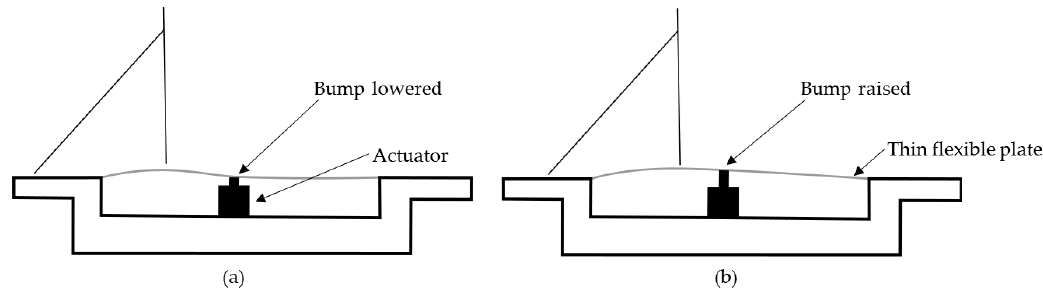
Figure 12. Schlieren images of an actuated flexible plate with ( a ) retracted and ( b ) extended actuator in a wind tunnel based on [81].